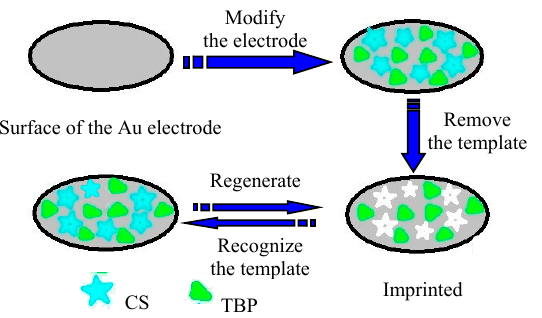
Figure 1. Schematic illustration of the 2,4,6-tribromophenol (TBP) electrochemical sensor fabrication. CS: chitosan [33]. CS: chitosan